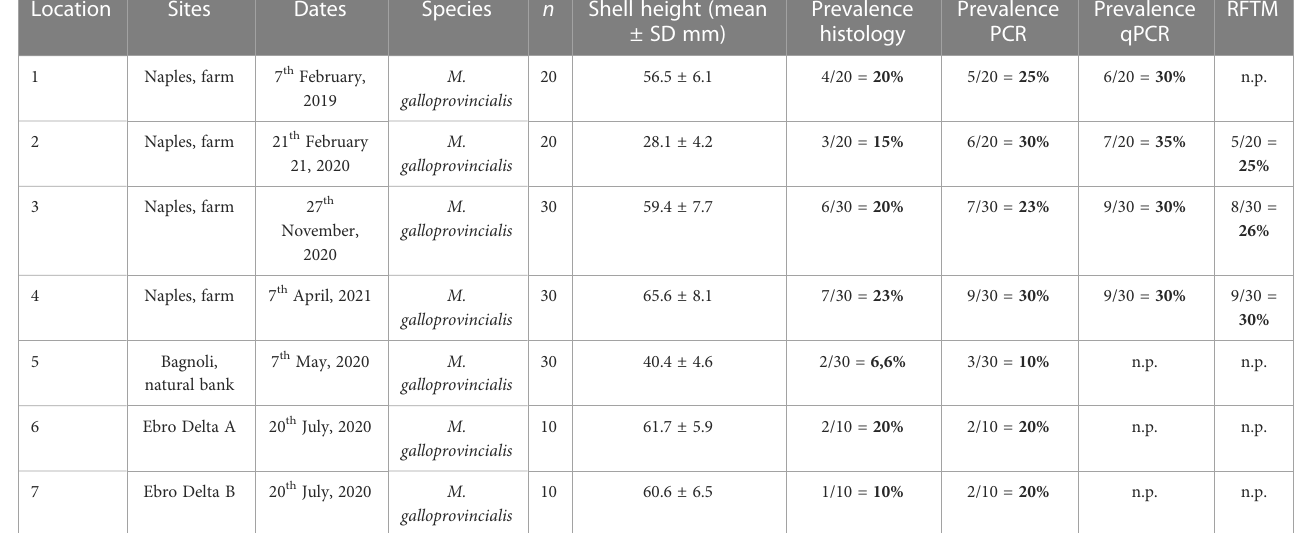
TABLE 2 Survey results of Perkinsus infection in the blue mussel, M. galloprovincialis collected from Campania region and Ebro Delta. n.p.: analysis not performed.